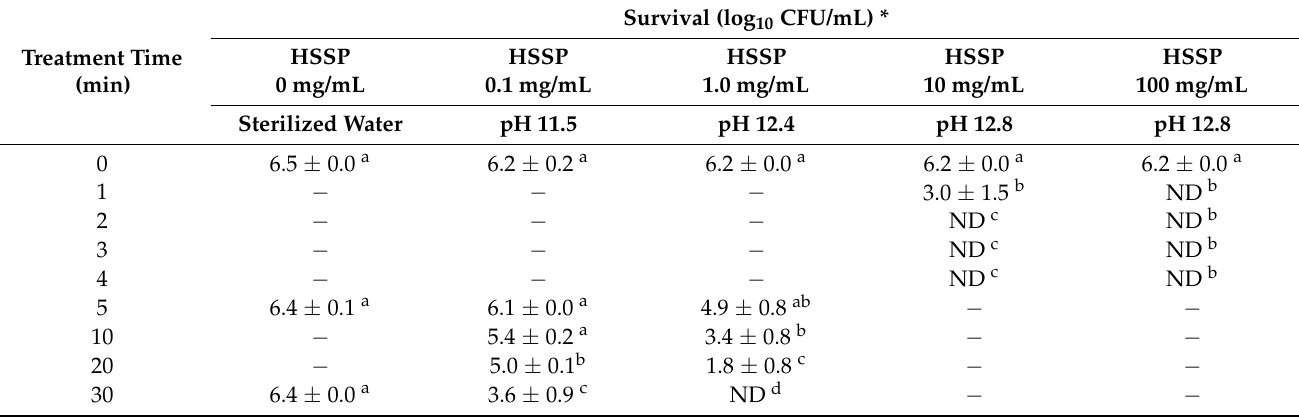
Table 2. Antibiofilm effects of HSSP on the biofilms of C. jejuni ATCC 29428 on filter paper. Treatment Time (min)